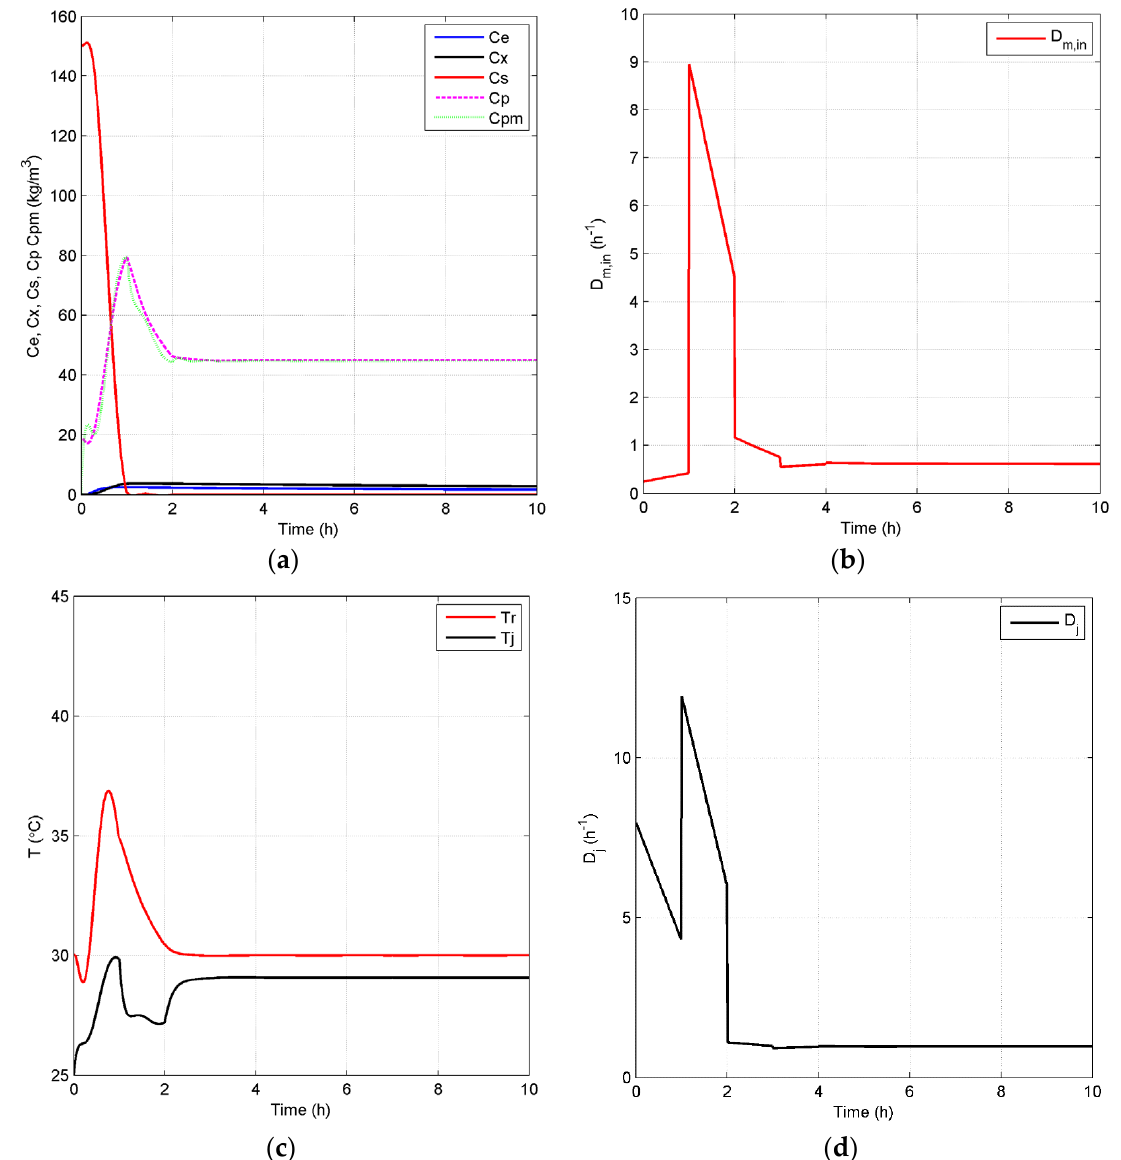
Figure 8. Closed-loop simulation profiles (Case 2): concentrations ( a ), D m,in ( b ), temperatures of the fermentor and jacket ( c ) and D j ( d ).